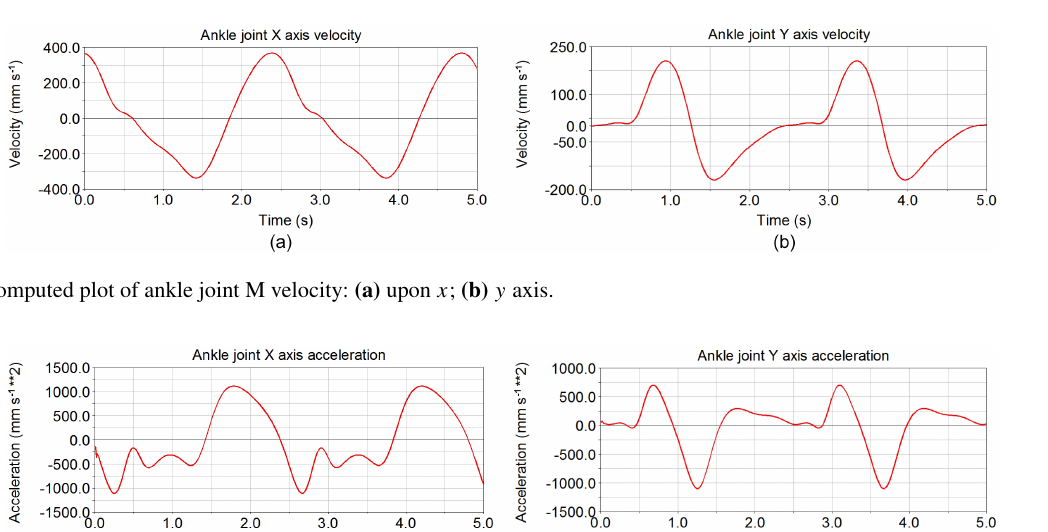
Figure 11. Computed plot of ankle joint M position: (a) upon x ; (b) upon y axis.